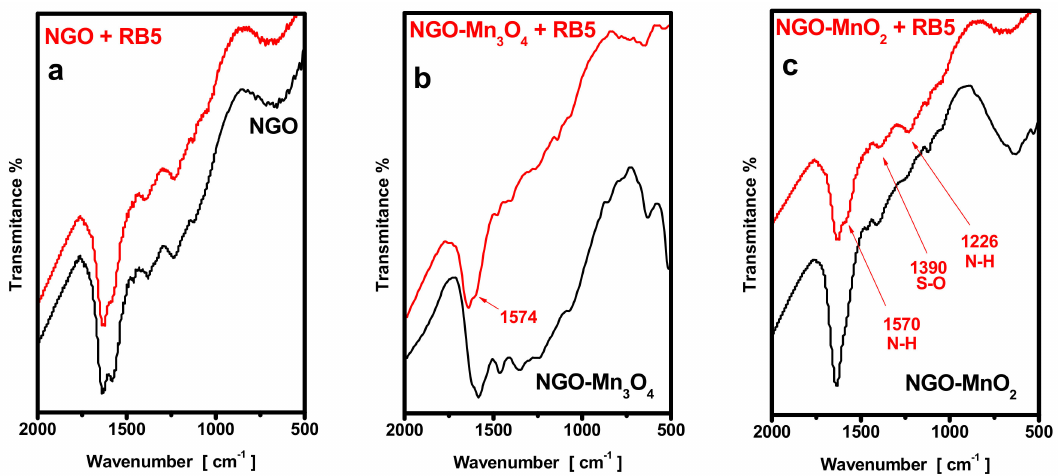
Figure 10. FTIR patterns of raw (black line) and after the RB5 degradation (red line) of NGO ( a ); NGO–Mn 3 O 4 ( b ) and NGO–MnO 2 ( c ) in presence of H 2 O 2